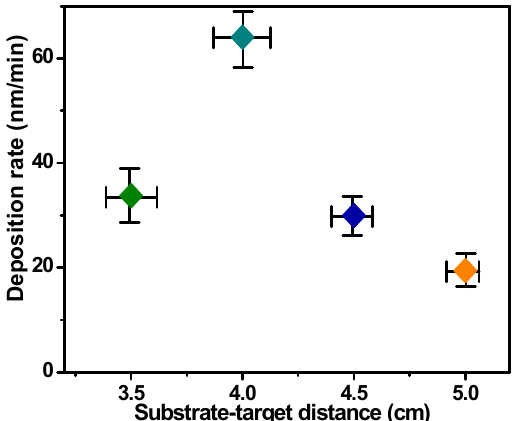
Figure 2. Deposition rate of CdTe films prepared by different sputtering distances.